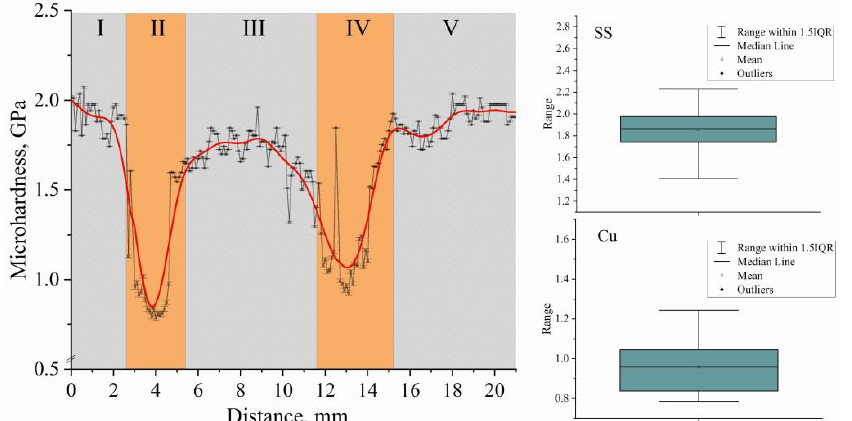
Figure 15. Dependence of the microhardness values on distance from substrate of the bimetallic layered macrocomposite sample. Block diagrams of microhardness measurements in the steel–copper boundary zone without jumps in values beyond the error limits.